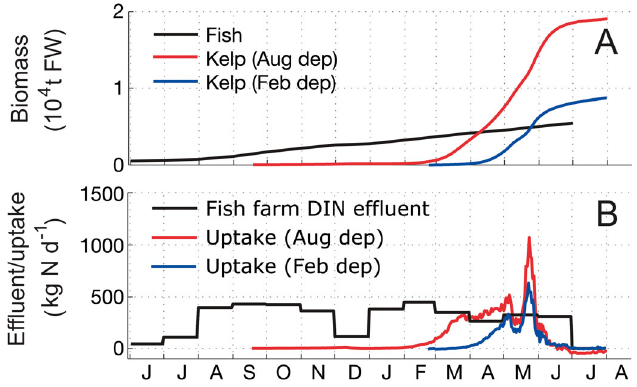
Table 6. Saccharina latissima . Key figures for simulated production and the nitrogen uptake potential of the hypothetical 100 ha S. latissima farm located close to the fish farm at Tristeinen (Figs. 1B & 15) in Simulations D (see Table 2), with harvest date in all cases on 15 June. Numbers in parentheses are minimum and maximum per hectare values within the 100 ha farm, respectively. FW: fresh weight; DW: dry weight